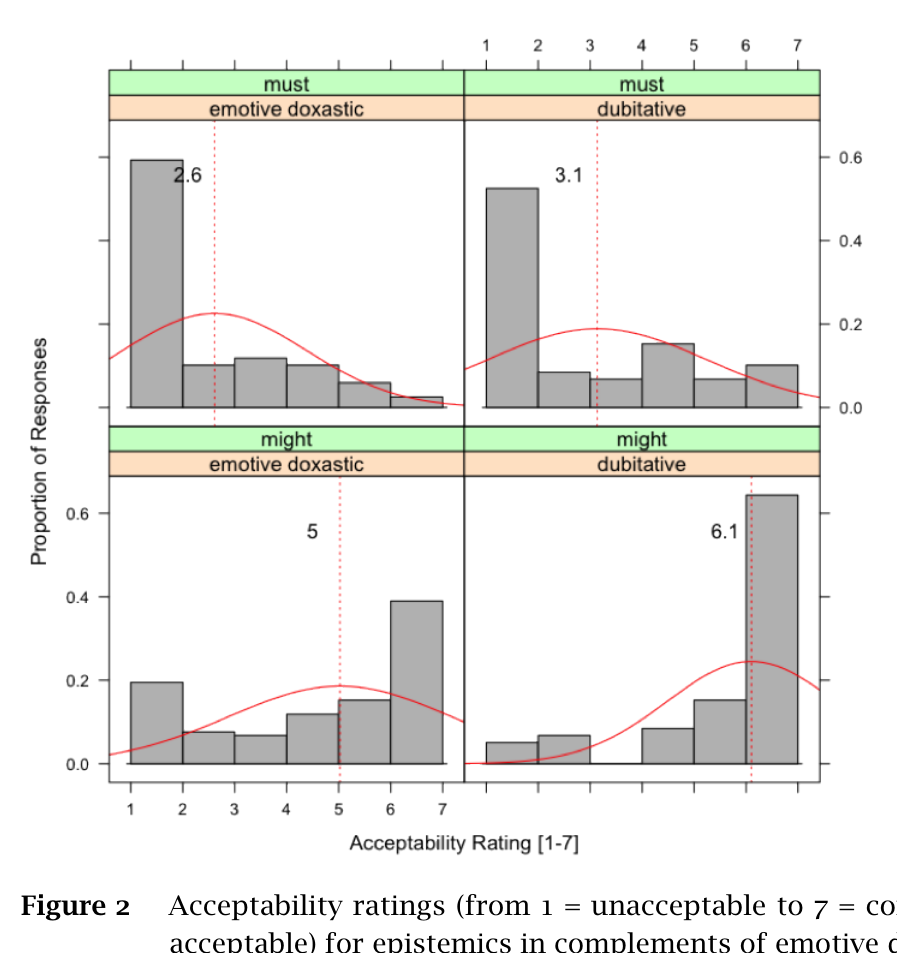
Figure 2 Acceptability ratings (from 1 = unacceptable to 7 = completely acceptable) for epistemics in complements of emotive doxastics and